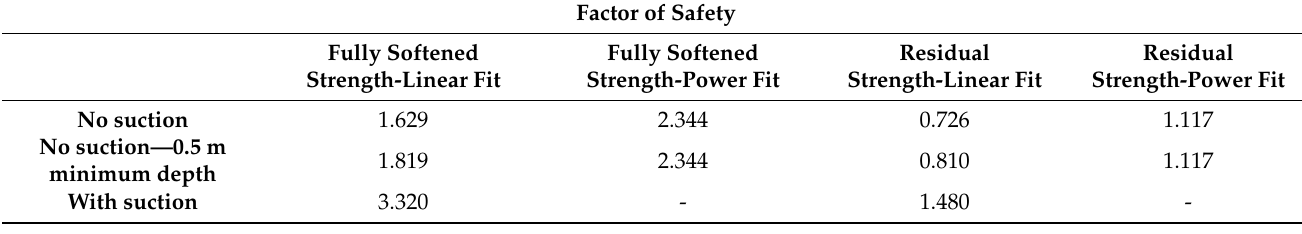
Table 4. Summary of minimum factors of safety for the different strength envelopes.